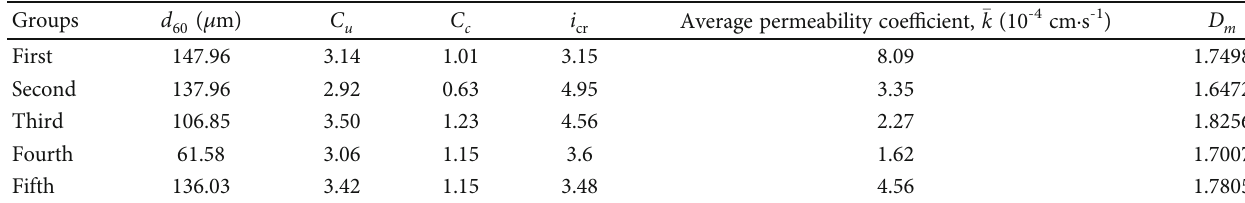
Figure 12: Relationship between D and porosity of tailing sand. ps Table 3: Comparison table of D m and particle size structure of tailing